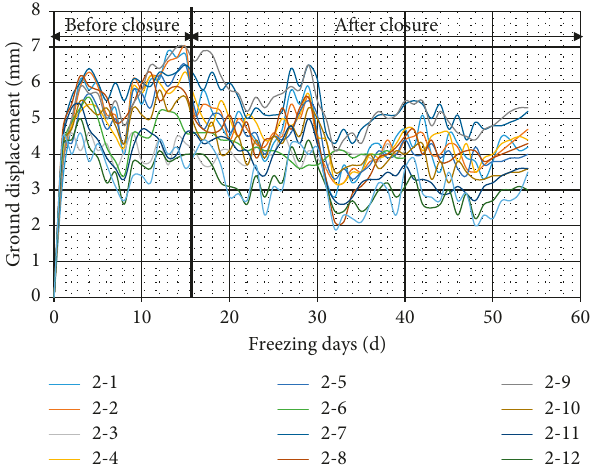
Figure 16: Ground displacement increment at DB2 section (positive values indicate ground